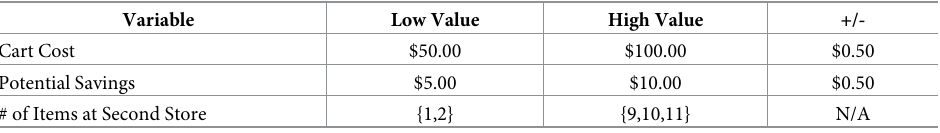
Table 1. Anchor values for each cart presentation (Study